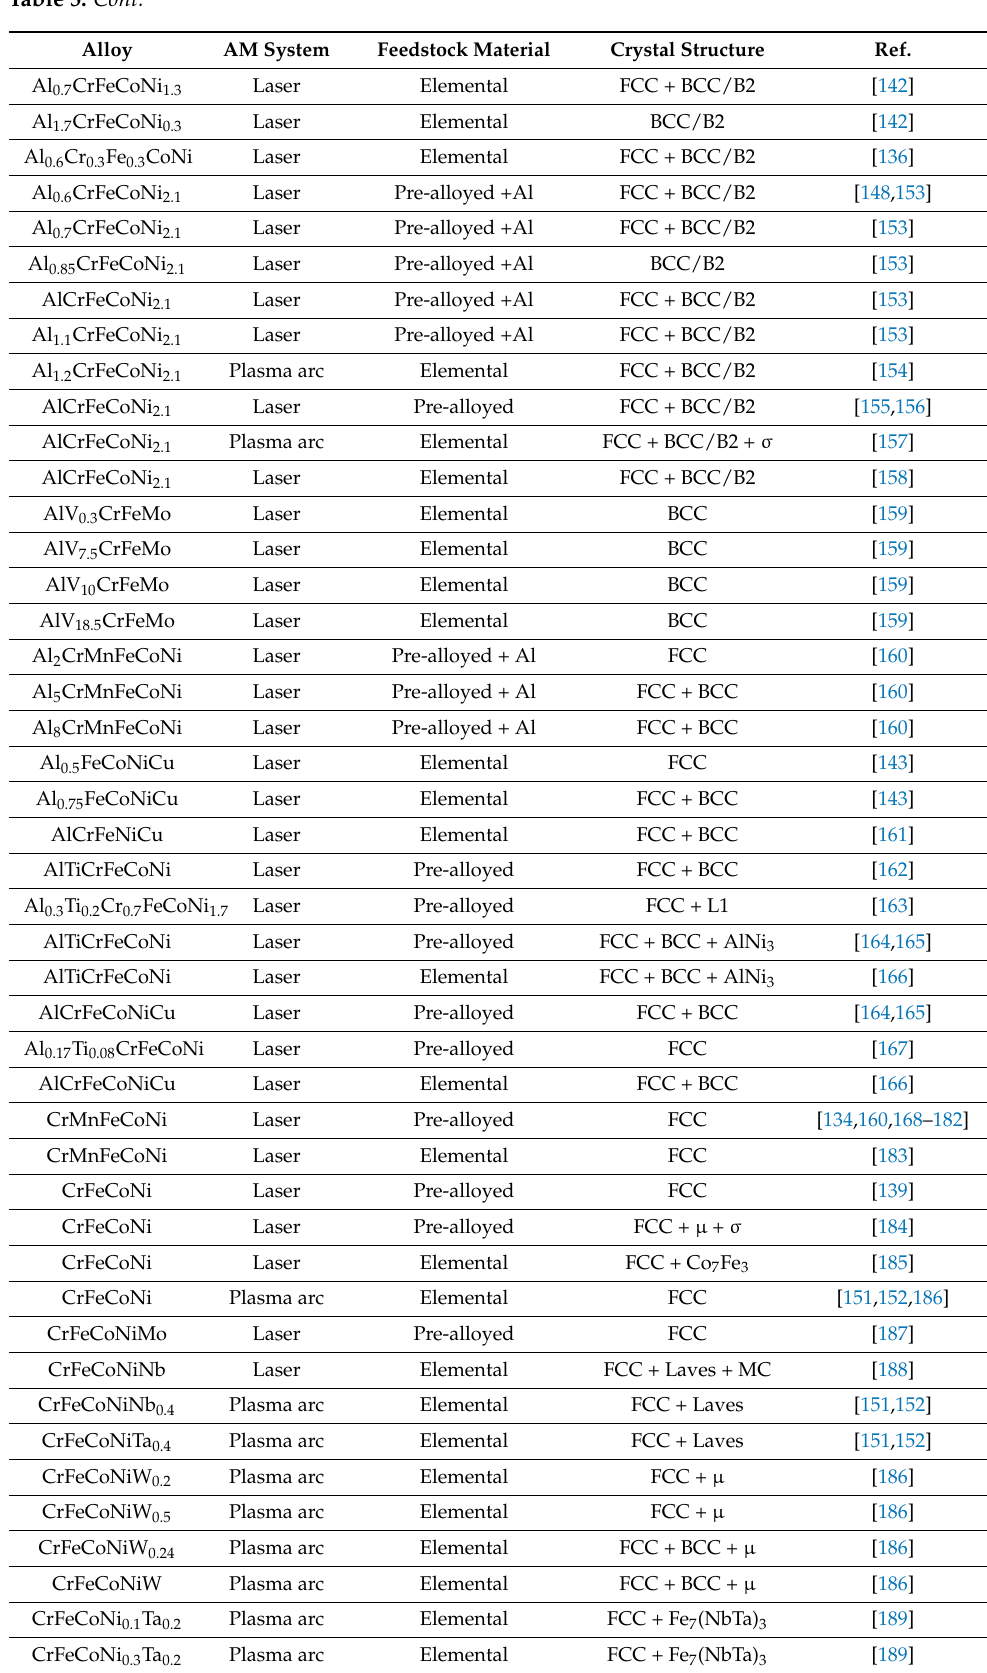
Table 5. Cont. Alloy AM System Feedstock Material Crystal